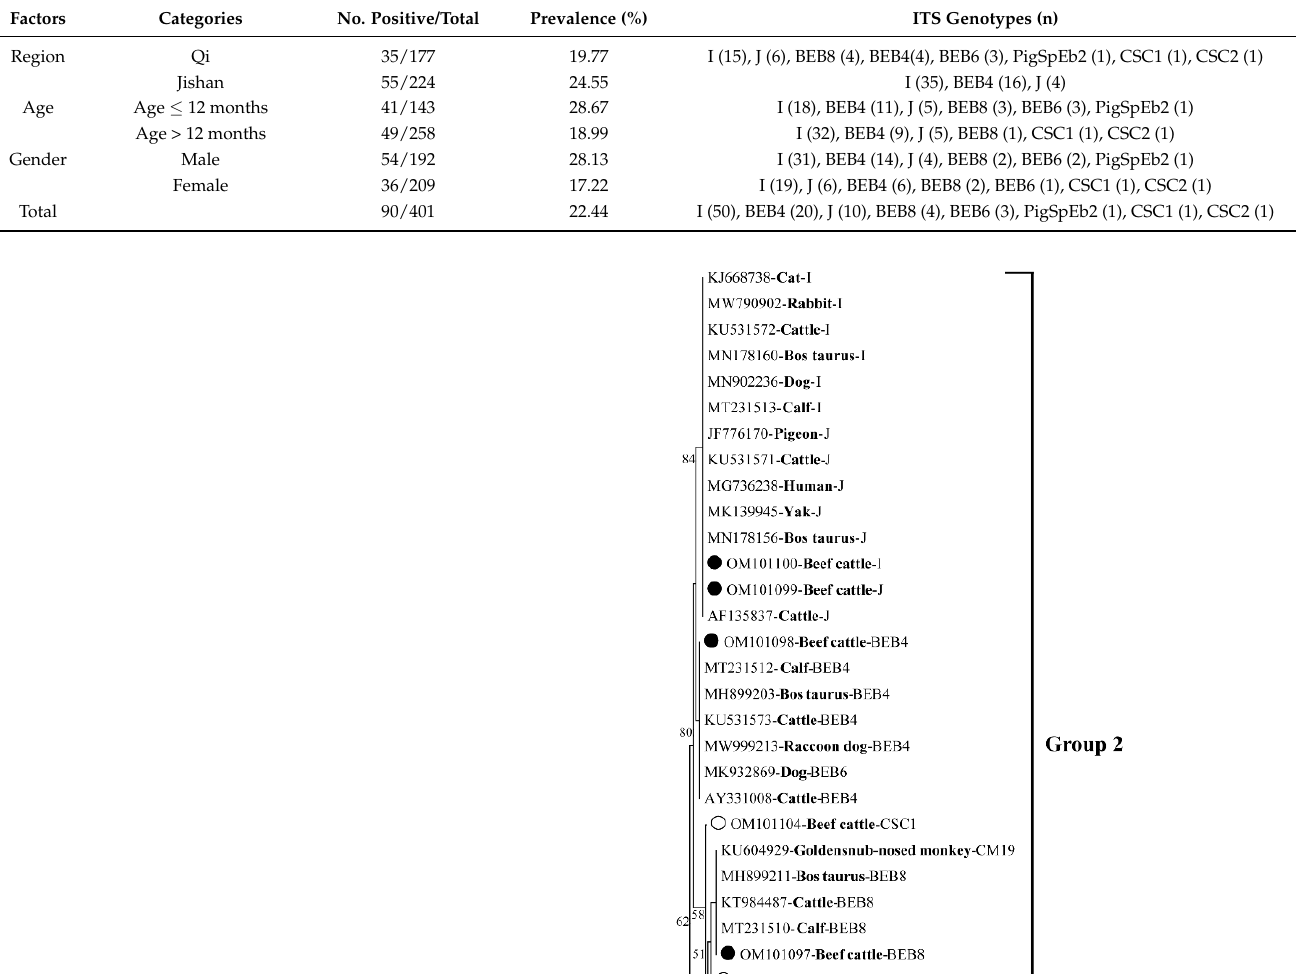
Table 2. Genotype distribution of Enterocytozoon bieneusi identified in beef cattle in this study.